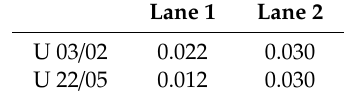
Table 2. Theil’s inequality coefficient .